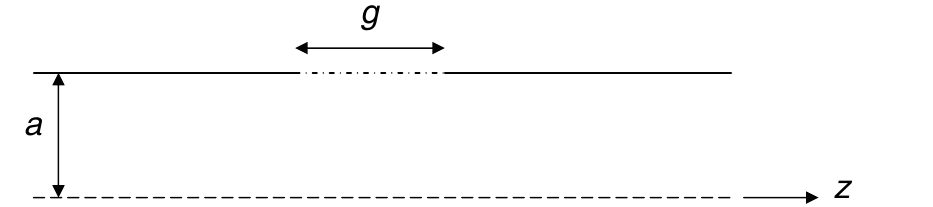
FIG. 1. Cylindrical tube of radius a , having finite conductivity (cid:3) in a section of length g , and infinite conductivity outside this